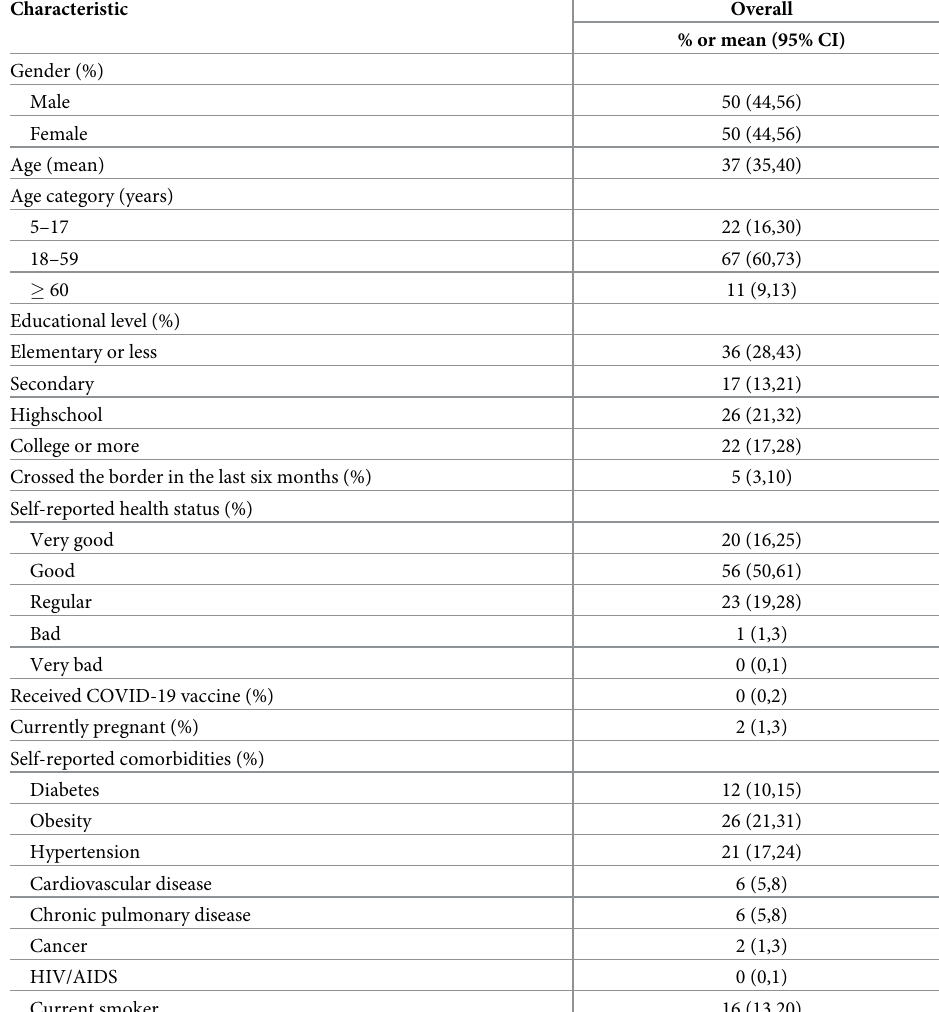
Table 1. Participant characteristics among a community-based sample of Baja California residents–February, 2021 a .